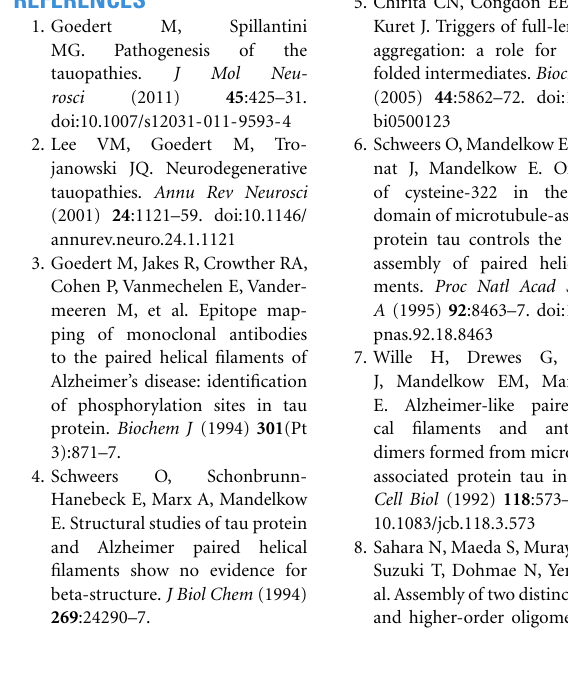
key toxicity-determining factors: levels of β -sheet structure and phosphorylation at certain sites may also be